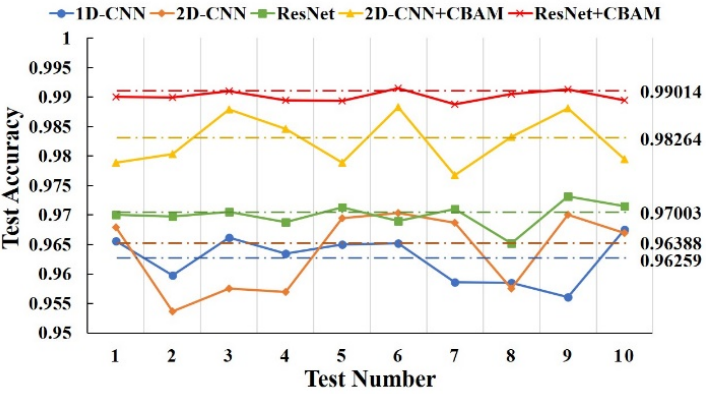
Figure 9. Ten-fold cross-validation of the five models. Figure 9. Ten ‐ fold cross ‐ validation of the five models. Figure 9. Ten ‐ fold cross ‐ validation of the five models.